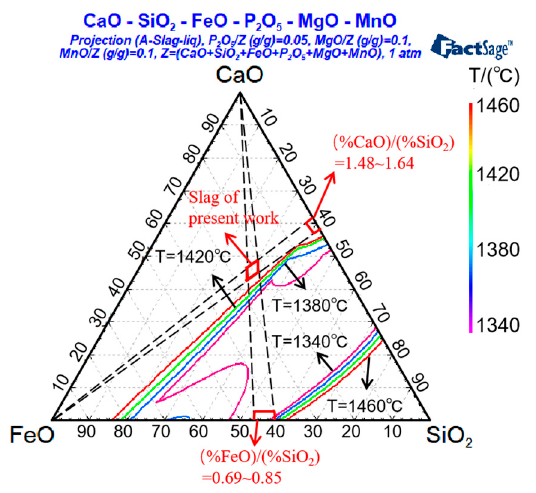
Figure 2. Effect of dephosphorization endpoint temperature on liquidus regions of the CaO-SiO 2 - FeO-10%MgO-10%MnO-5%P 2 O 5 dephosphorization slag.